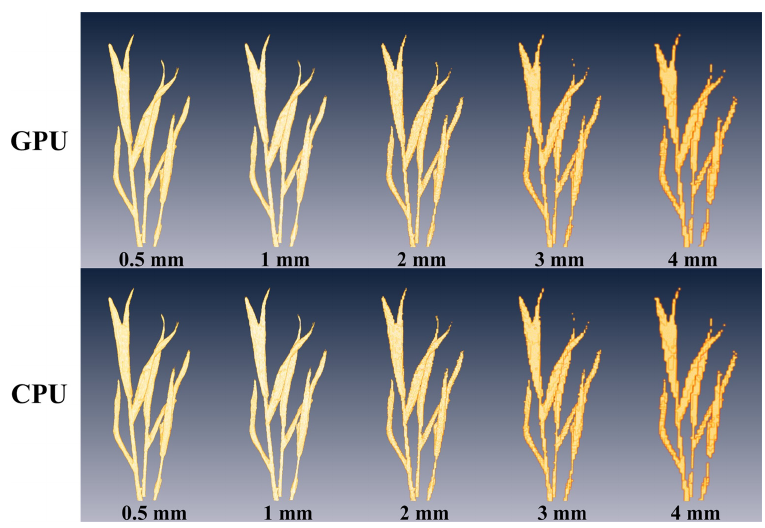
Fig. 9. Reconstruction results for di®erent voxel sizes obtained using the CPU and the